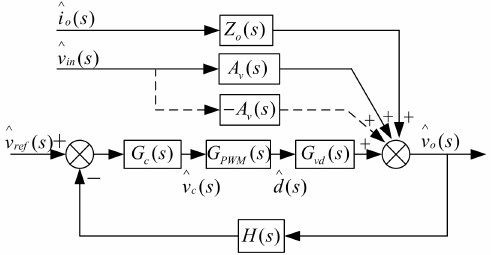
Figure 8. The small-signal control block.